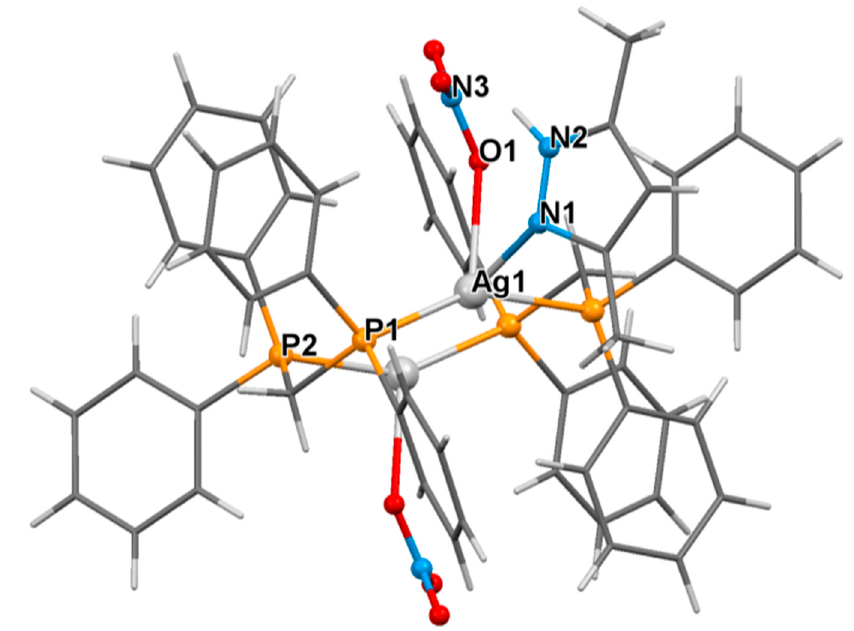
Figure 3. XRD structure of the complex 2 (carbon and hydrogen atoms are shown as sticks).